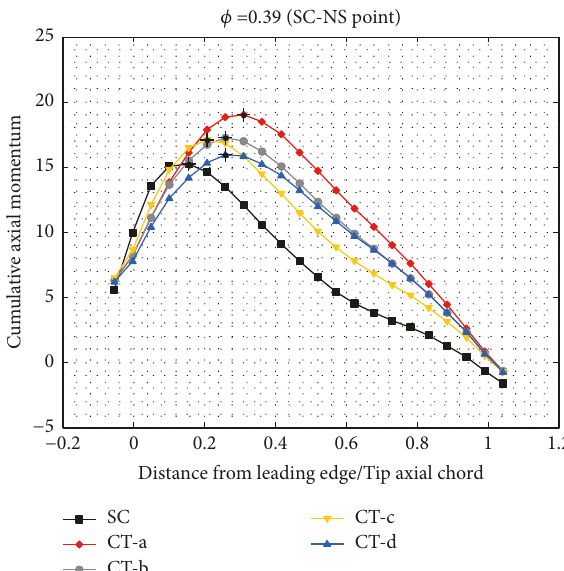
Figure 17: The bell-shaped curves for the four different axial-slots configurations together with that of the smooth casing ([18]). Figure reproduced from MA (2016).